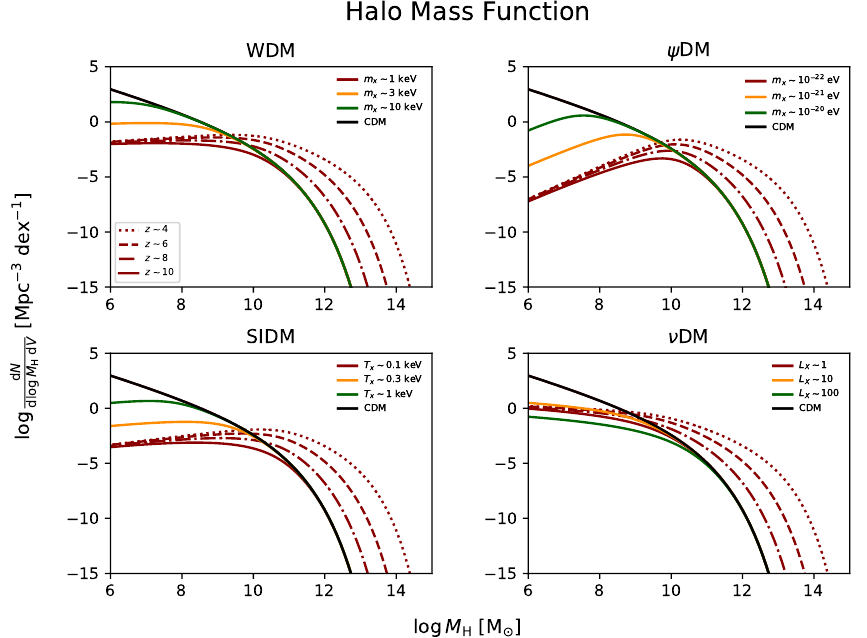
Figure 2. The halo mass function in different DM scenarios. Different line styles illustrate the evolution with redshift (only plotted for one value of the astroparticle property), as reported in the legend. Different colors illustrate the change in the mass function at z ∼ 10 as a function of the astroparticle property, as detailed in the legend; for reference, the black line refers to the standard